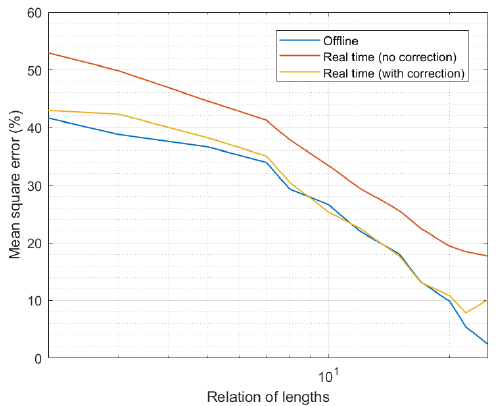
Figure 5. Results of the third experiment.